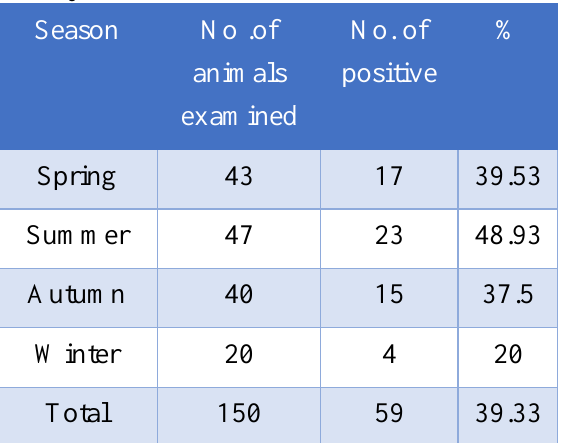
Table, 5: Infection rate of bovine theileriosis by microscopic examination according to seasons of study.